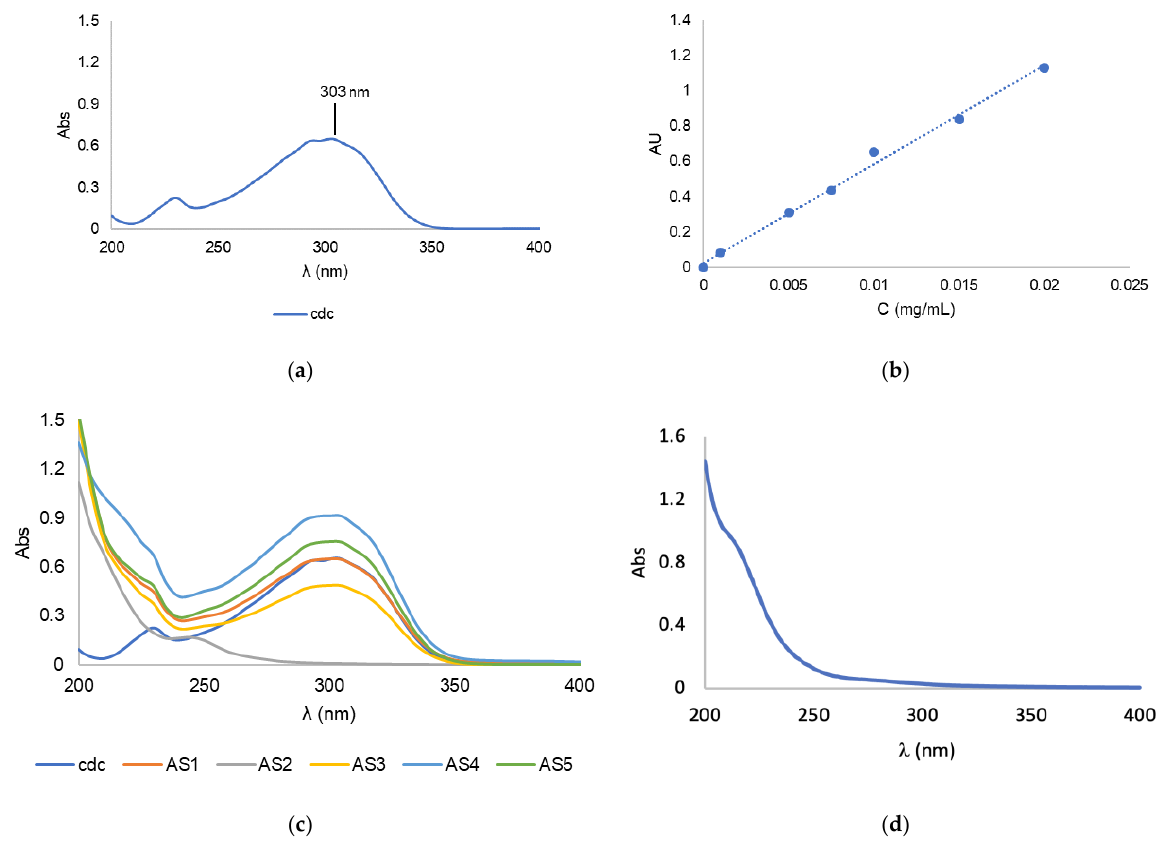
Figure 3. ( a ) UV-vis spectrum of [Au(cdc) 2 ] − ; ( b ) Calibration curve of [Au(cdc) 2 ] − at λ = 303 nm; ( c ) UV-Vis spectra of [Au(cdc) 2 ] − and BCMs-[Au(cdc) 2 ]; ( d ) UV-vis spectrum of non-loaded BCMs.